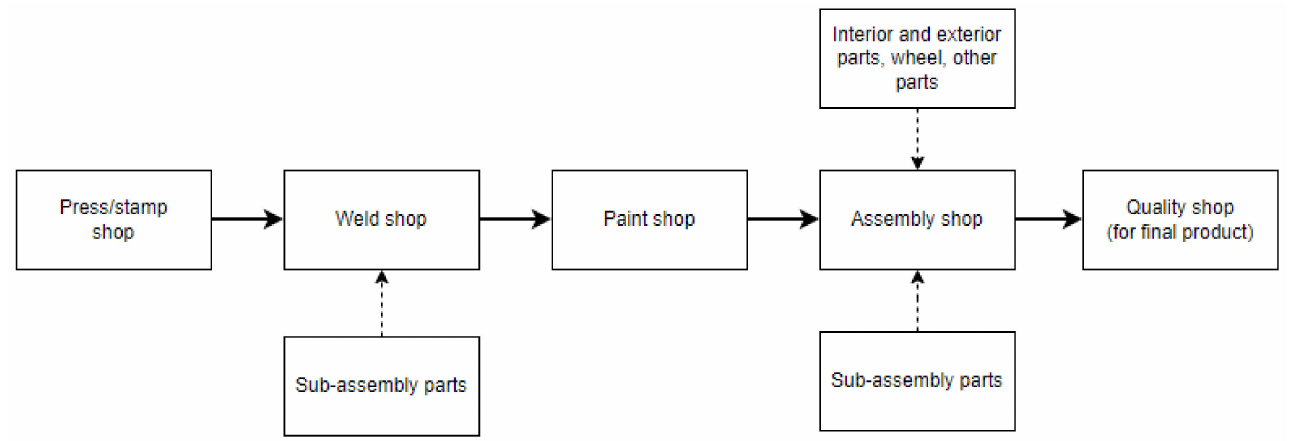
Figure 1. A general automotive manufacturing